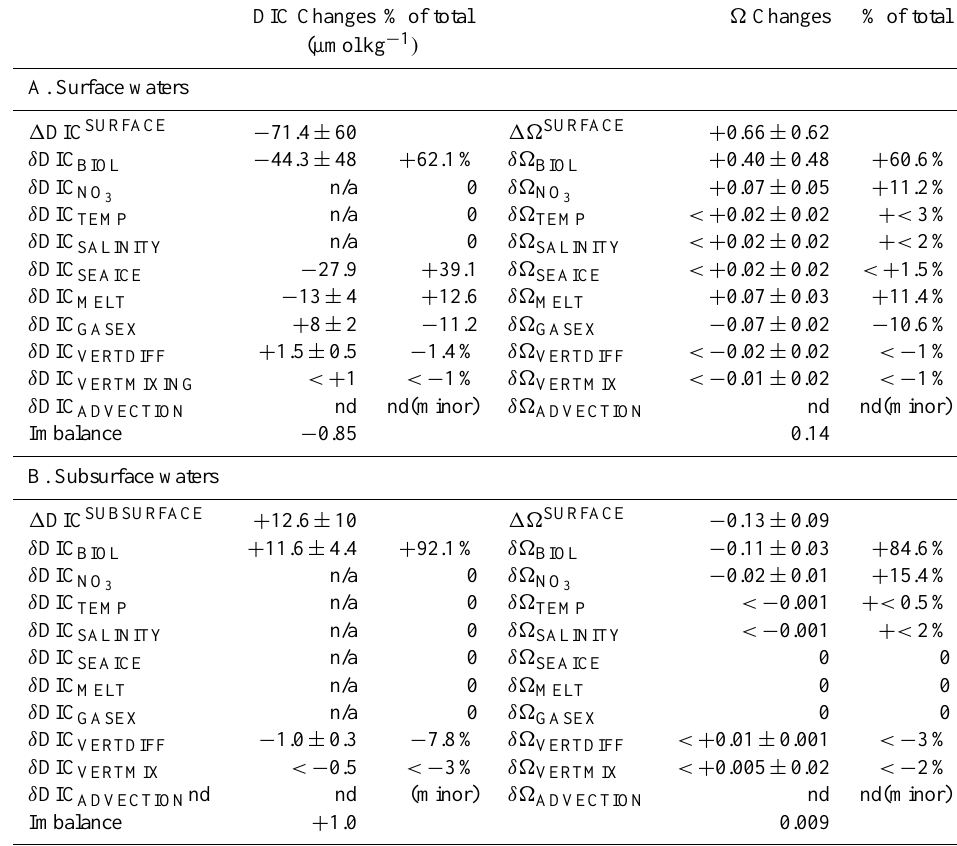
Table 3. Physico-biogeochemical contributors to seasonal changes in DIC and (cid:127) between winter/early-spring conditions and summertime conditions during the 2009–2011 RUSALCA/ICESCAPE expeditions in the western Arctic Ocean. nd = not